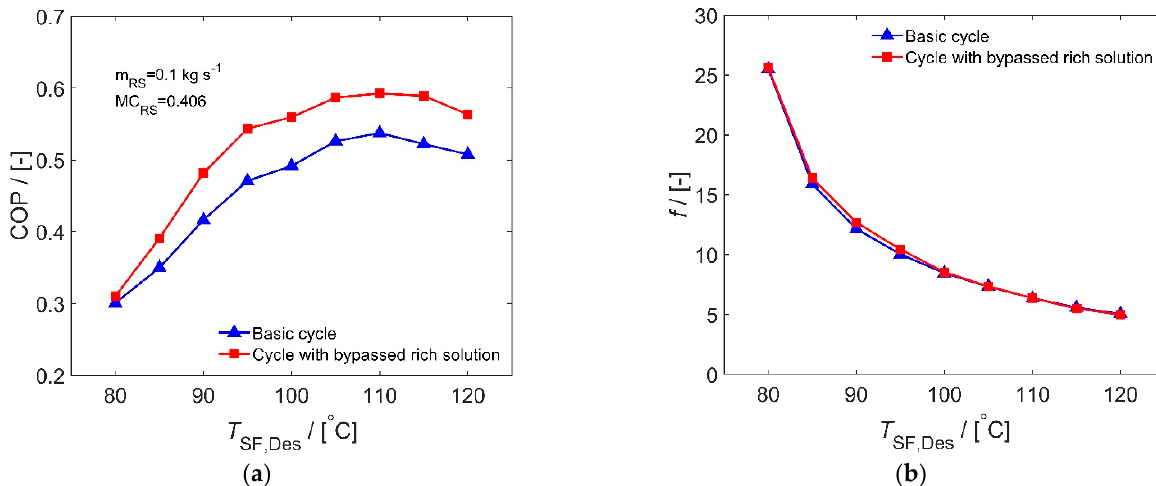
Figure 13. Performances of cycle with bypassed rich solution and basic cycle as a function of heat source temperature. Cycle performances are ( a ) COP, ( b ) Solution circulation ratio.